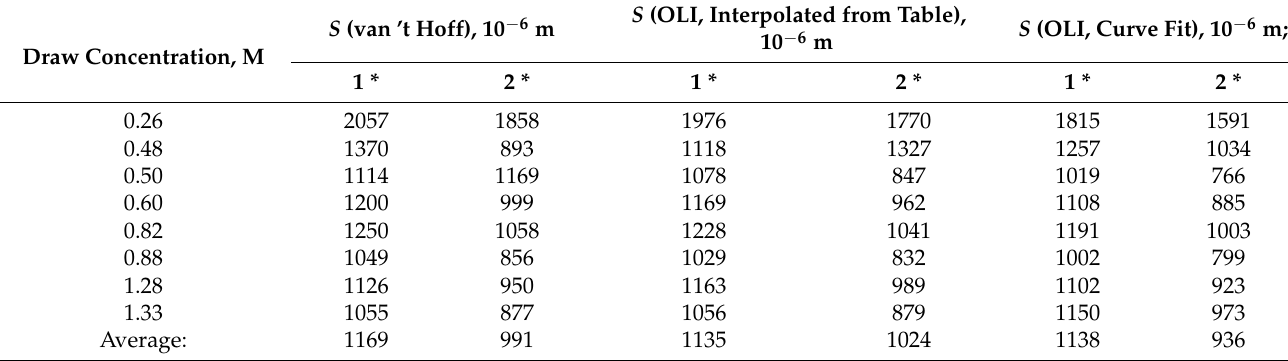
Table 4. Predicted values of the structural parameter for the Porifera membrane as a function of draw salt concentration. DI is used for feed phase; the osmotic pressure was predicted by the van ’t Hoff approach and by the OLI software, using the curve-fit expression ( π = 5.94028 C 2 + 37.4521 C for C > 0.6) and also the linear interpolation of the OLI data given in Ref. [35], for calculation of the structural parameter, S , with ( k d = k f = 2 × 10 − 5 m/s) and without external mass transfer resistances ( k d = k f → ∞ ).